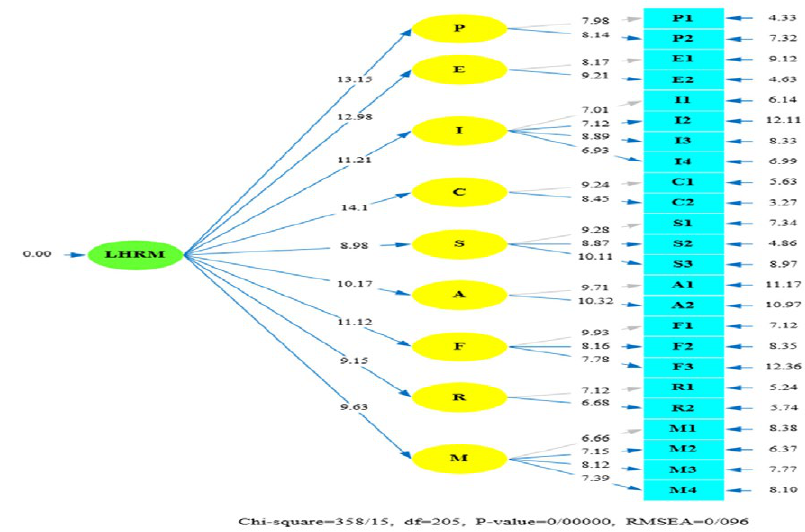
Fig. 2: Results of the significant numbers relating to the “LHRM model in the Islamic City Council of Tehran”